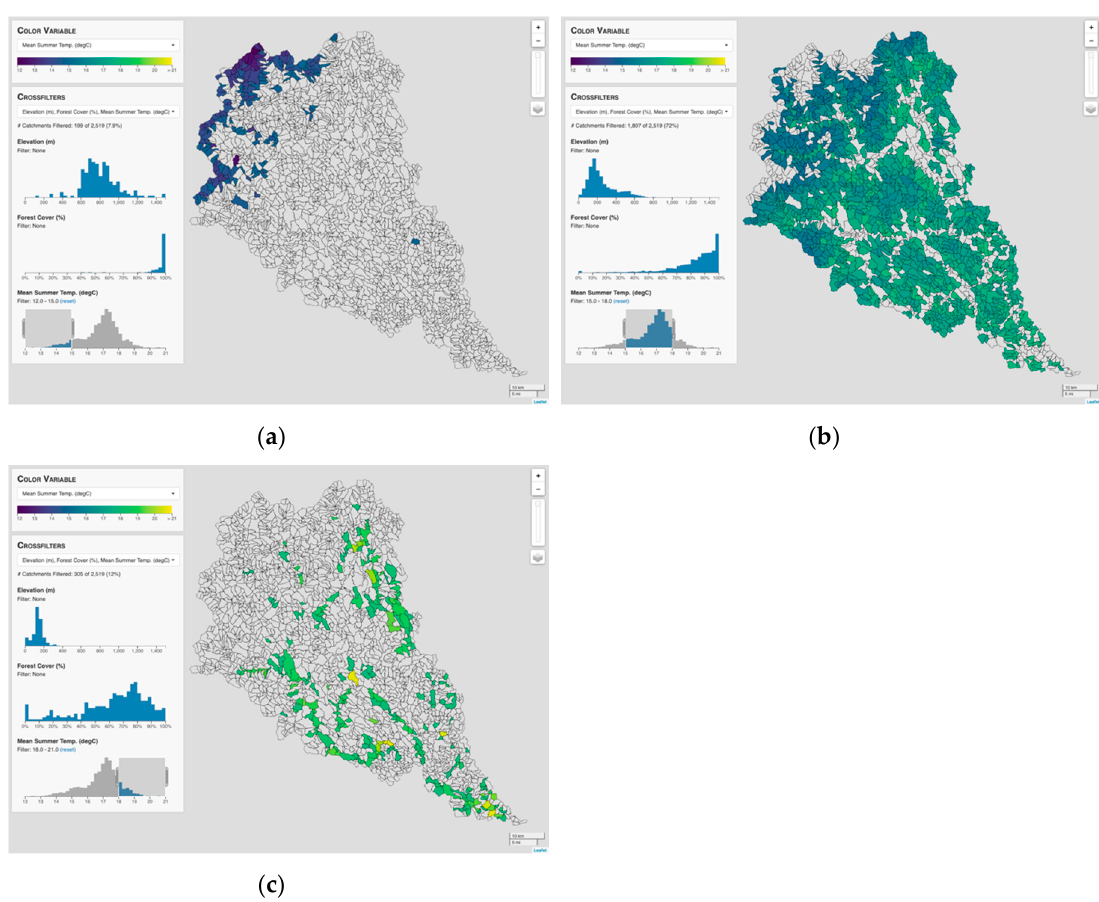
Figure 4. Screenshots demonstrating crossfilter interaction by filtering catchments by mean summer stream temperature over varying ranges including ( a ) 12–15 °C, ( b ) 15–18 °C and ( c ) 18–21 °C.